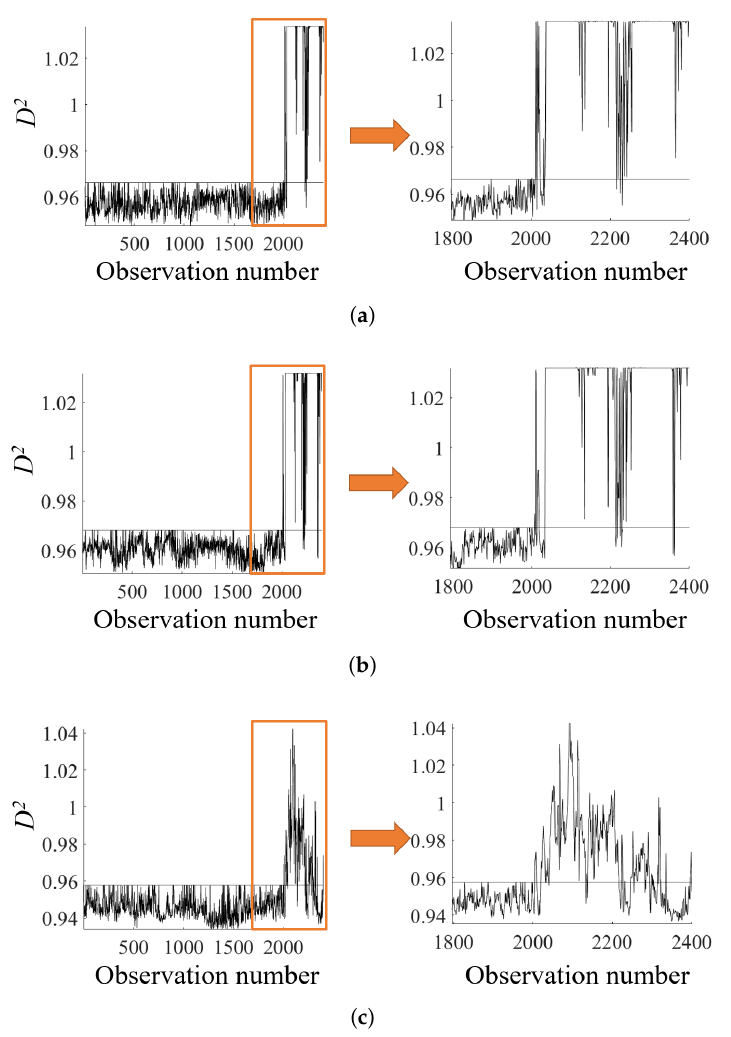
Figure 7. Monitoring results for the hanging fault. ( a ) Monitoring results of GRU-SVDD, ( b ) Monitoring results of LSTM-SVDD, ( c ) Monitoring results of principal component analysis